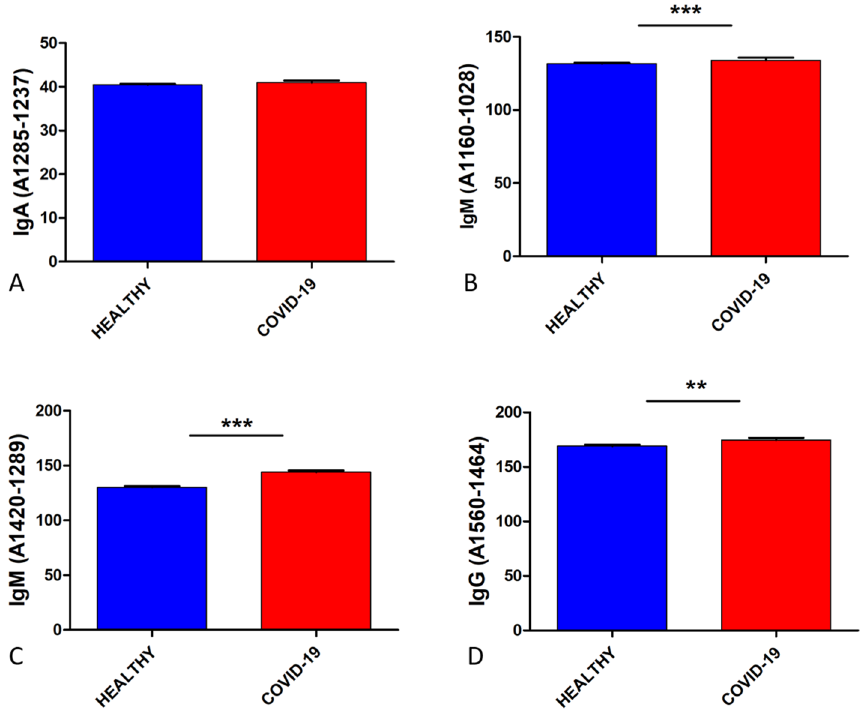
Figure 3. Immunoglobins content comparison between healthy (N = 1209) and COVID-19 (N = 255) groups. ( A ) IgA (1285–1237 cm −1 ), ( B ) IgM (1160–1028 cm −1 ), ( C ) IgM (1420–1289 cm −1 ), ( D ) IgG (1560–1464 cm −1 ). The three immunoglobulins showed a higher expression in the COVID-19 group, showing statistical significance IgM and IgG. Means of immunoglobins expression with error bars representing the standard deviation are depicted, **p < 0.05 and ***p < 0.005, compared to the healthy group.